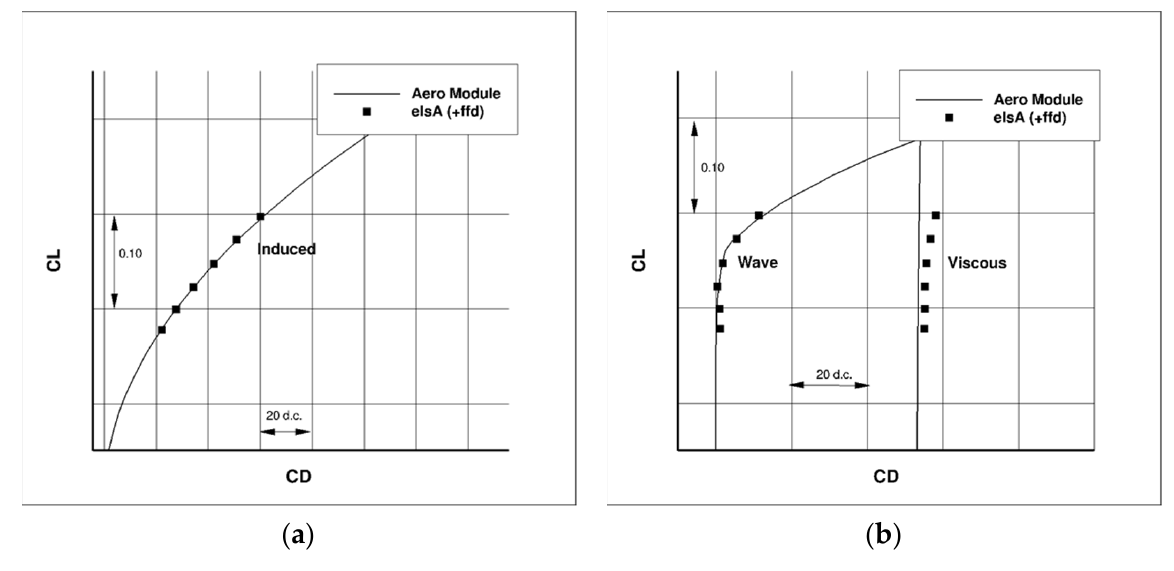
Figure 31. AVECA BWB configuration—drag components. Lines—aerodynamic module; symbols—CFD. ( a ) Lift-induced. ( b ) Wave and viscous.